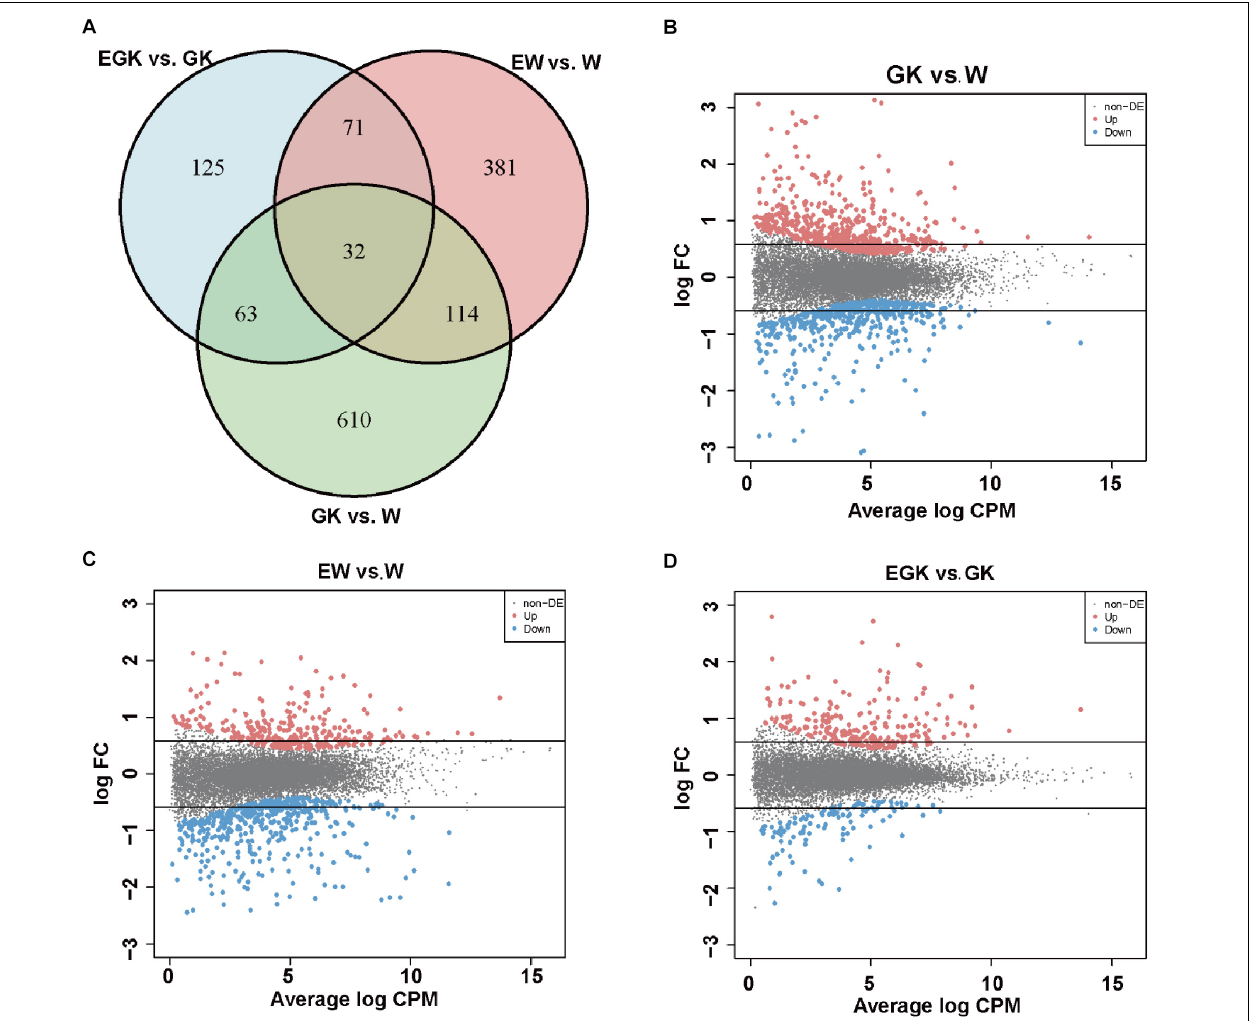
FIGURE 1 | The number of DEGs. (A) Venn diagram representing the overlap of DEGs in skeletal muscle among the three comparisons (GK vs. W, EGK vs. GK, and EW vs. W). MA plots representing the distribution of DEGs in GK (B) , EW (C) , and EGK (D) . The dots between two horizontal lines indicate absolute fold change < 1.5, red dots indicate significantly upregulated genes, and blue dots indicate significantly downregulated genes (FDR < 0.05). W, Wistar; EW, exercise Wistar; GK, Goto-Kakizaki; EGK, exercise